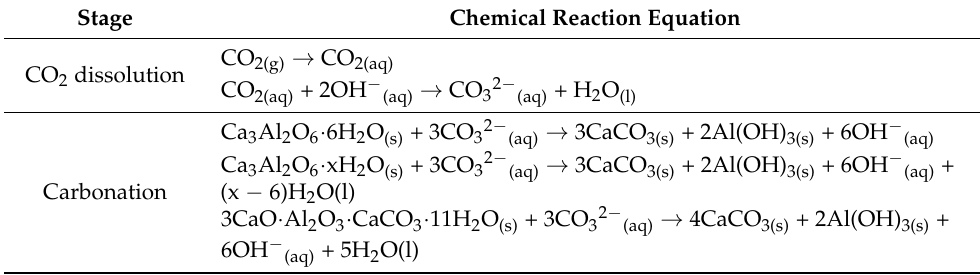
Figure 6. FESEM pictures of ( a ) carbonated 20H-slag, ( b ) carbonated 40H-slag, ( c ) carbonated 60H-slag, ( d ) carbonated 80H-slag, and ( e ) carbonated 100H-slag. Table 4. Chemical reaction equations of the direct carbonation of the pretreated slags in this study. Stage